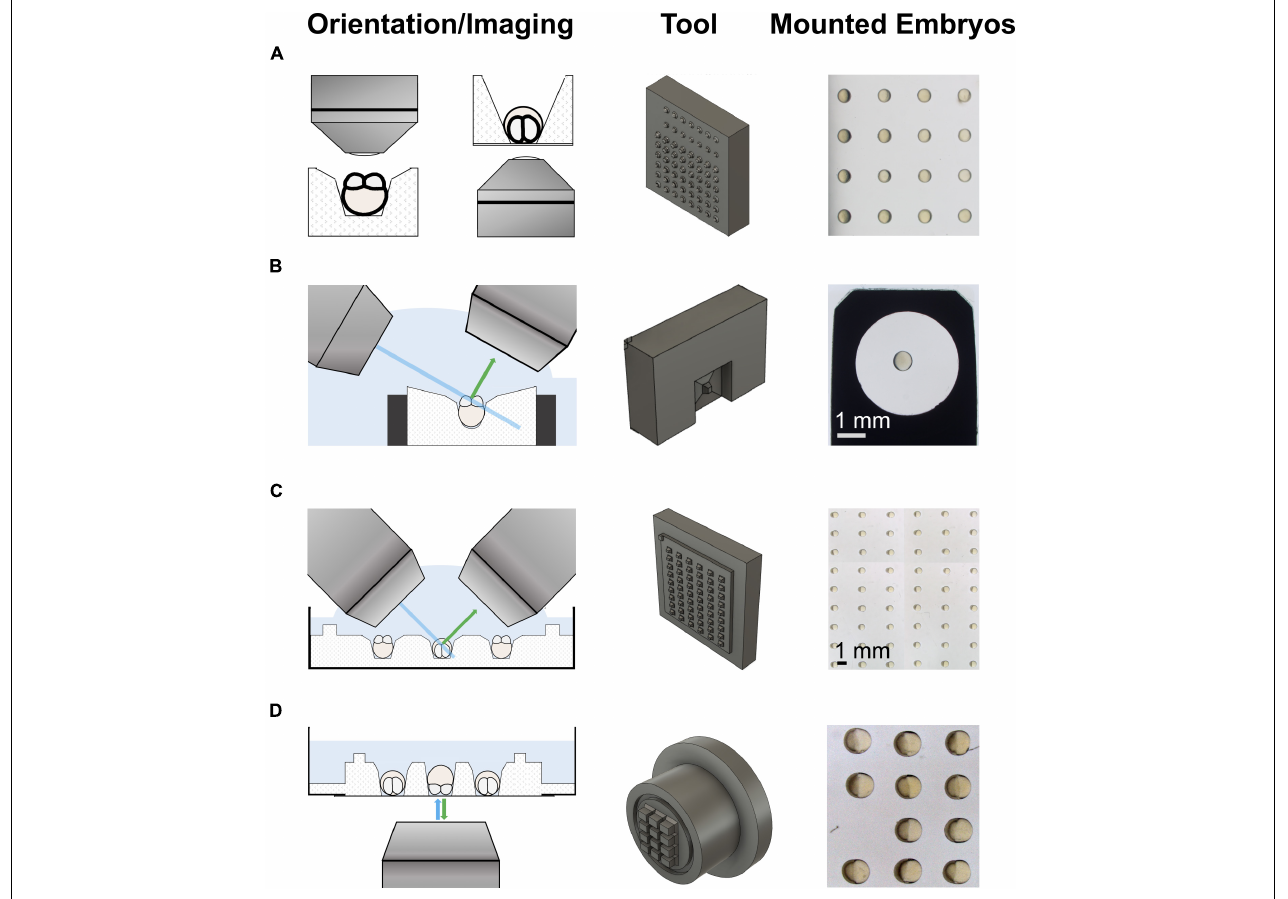
FIGURE 1 | 3d-printed tools for imaging on upright and inverted microscopes. The left column shows schematics of the different imaging modalities. The middle column shows the 3d-printed mounting tools. The right column shows examples of embryos mounted using the tools. (A) An iterative design strategy was used to optimize pins on 3d-printed mounting tools for different imaging modalities on upright (left) and inverted (right) microscopes. (B) Tool to mount embryos in a holder used for imaging on a lattice light-sheet microscope (LLSM). (C) Tool to mount embryos in a Petri dish for imaging on an upright microscope, such as a diSPIM. The pins sit on a plate with a slight offset from the actual tool block. This generates a shallow pool on the imaging plate after removal of the medium, allowing direct access for water dipping lenses to image the mounted embryos. (D) Tool to mount embryos in a glass-bottom dish for imaging on an inverted microscope, e.g., by spinning disk microscopy. Similar to the tool for Petri dishes, this tool has a feature to produce shallow wells for mounting, a trench that runs around the